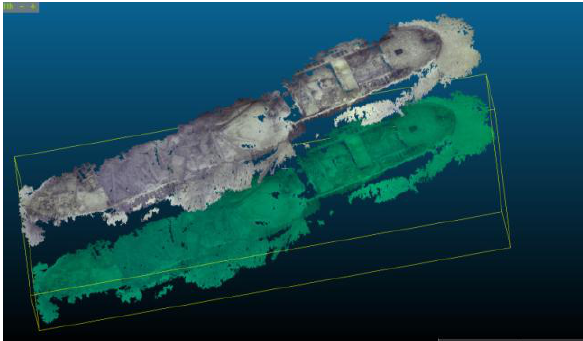
The color and contrast enhanced filters -through the same algorithms selected for the images- are applied to the 3D colored point cloud. Since the LAB and ACE algorithms used do not contain spatial considerations, which is very common in other types of image enhancement algorithms, the improvement of color and contrast works correctly on the synthetic image generated. After the enhancements are applied to this synthetic image, the new RGB values are restored to the points of the 3D cloud, associating them again with their spatial component (Fig. 7). The filters LAB + ACE obtain similar results with the complete 3D point cloud than individual scenes.